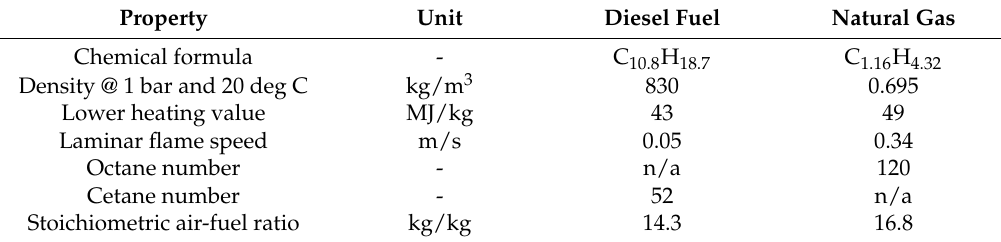
Table 2. Basic characteristics of the fuels used